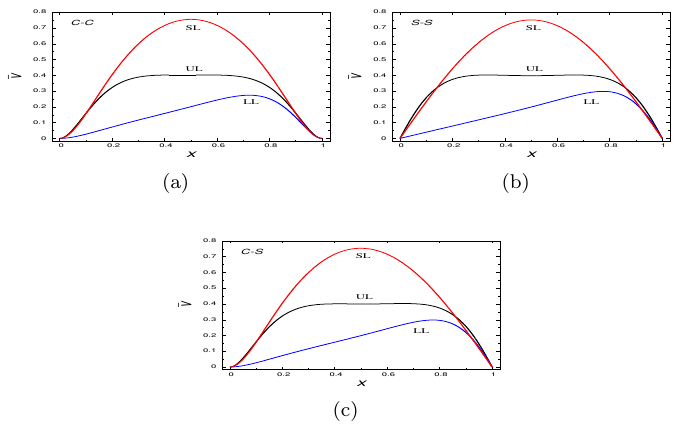
Figure 11. Effect of different loads on the distribution of angular displacement along the axial direction of a CNT subjected to: (a) C-C , (b) S-S , and (c) C-S boundary conditions.